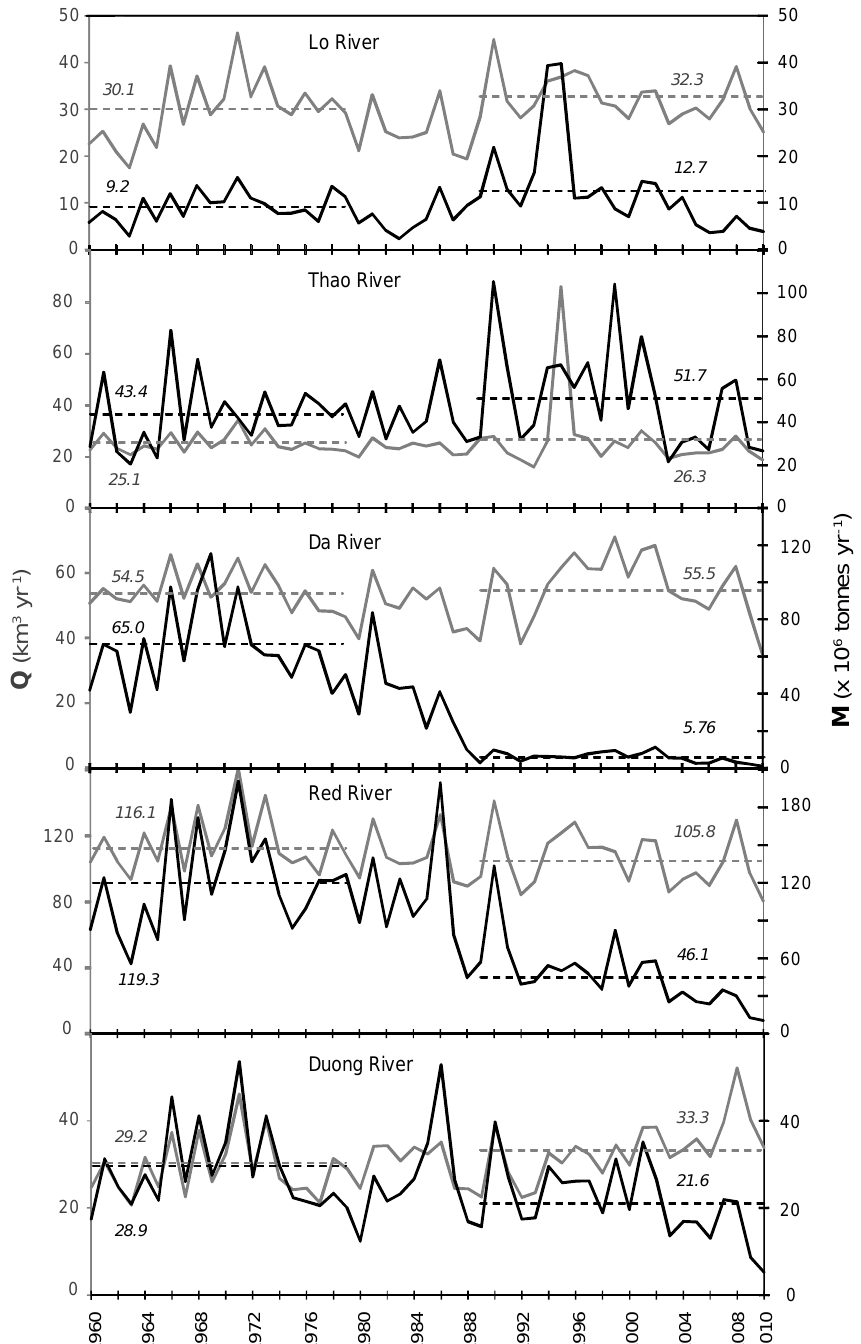
Figure 4. Annual water and suspended sediment discharge in the main tributaries of the Red River system (1960–2010), and average values before and after Hoa Binh dam